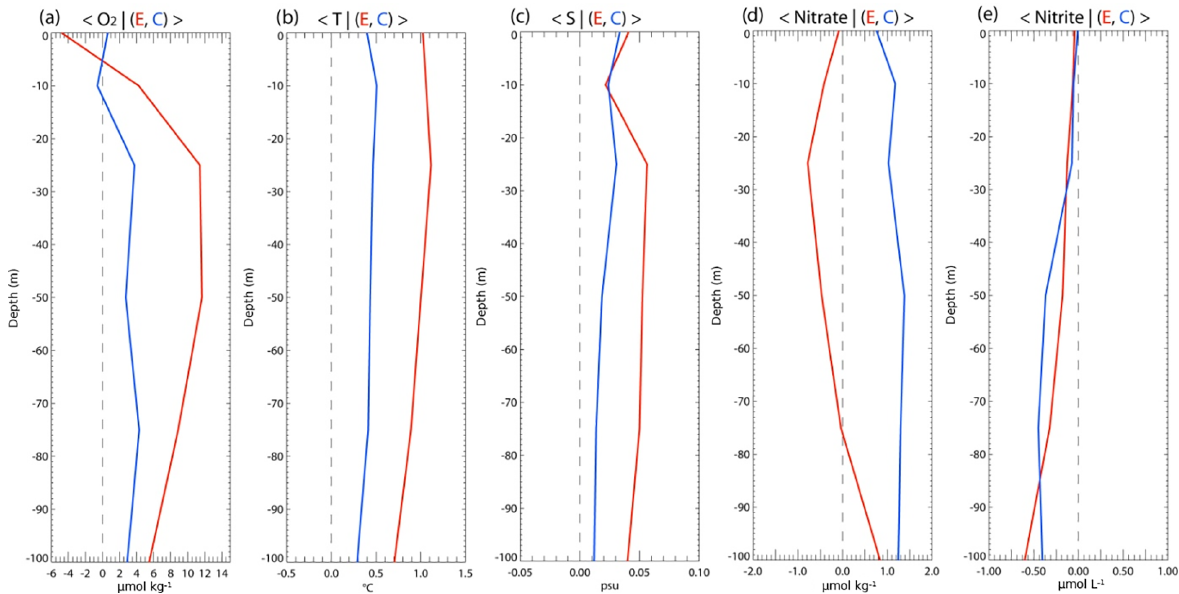
Figure 6. Projection of the data onto the (red line) E and (blue line) C indices for (a) oxygen, (b) temperature, (c) salinity, (d) nitrate and (e)